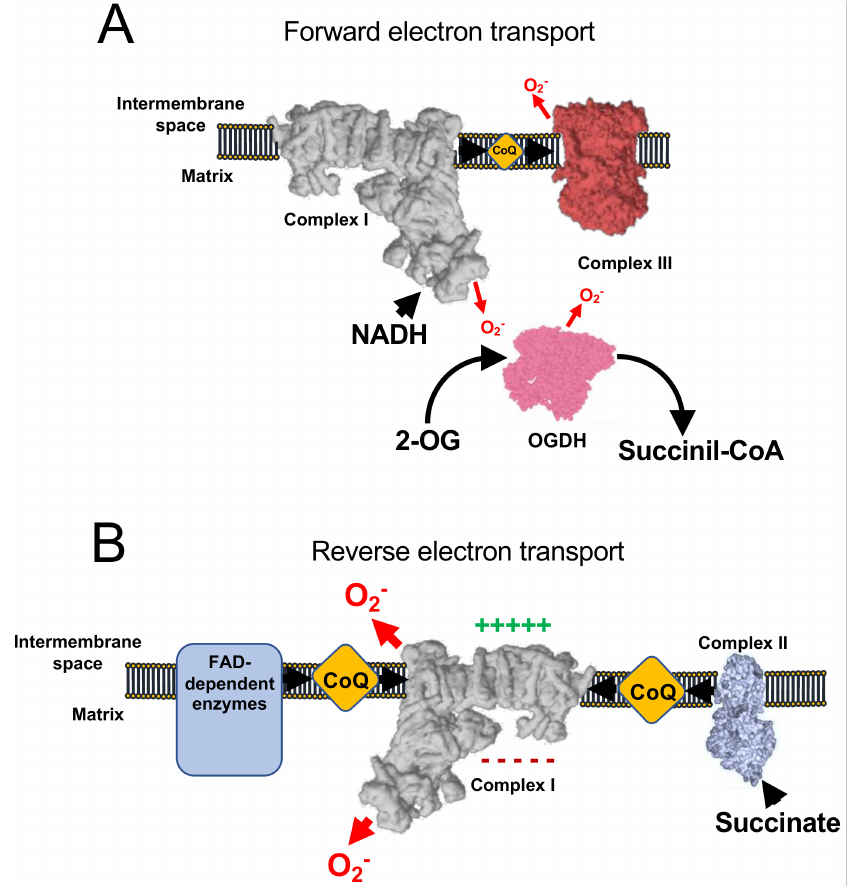
Figure 2. ROS production involving respiratory Complex I. ( A ) Under normal conditions, minimal amount of mitochondrial ROS are produced, nicotinamide adenine dinucleotide hydrogen (NADH) is oxidized at a high rate, as well as ubiquinol and 2-oxoglutarate. ( B ) Under conditions of normal- to-high ∆Ψ m and accumulation of reduced CoQ (or succinate) complex I works in the reverse mode, producing high rates of ROS. In addition, a few flavin adenine dinucleotide (FAD)-dependent enzymes have also been shown to contribute to reverse electron transfer